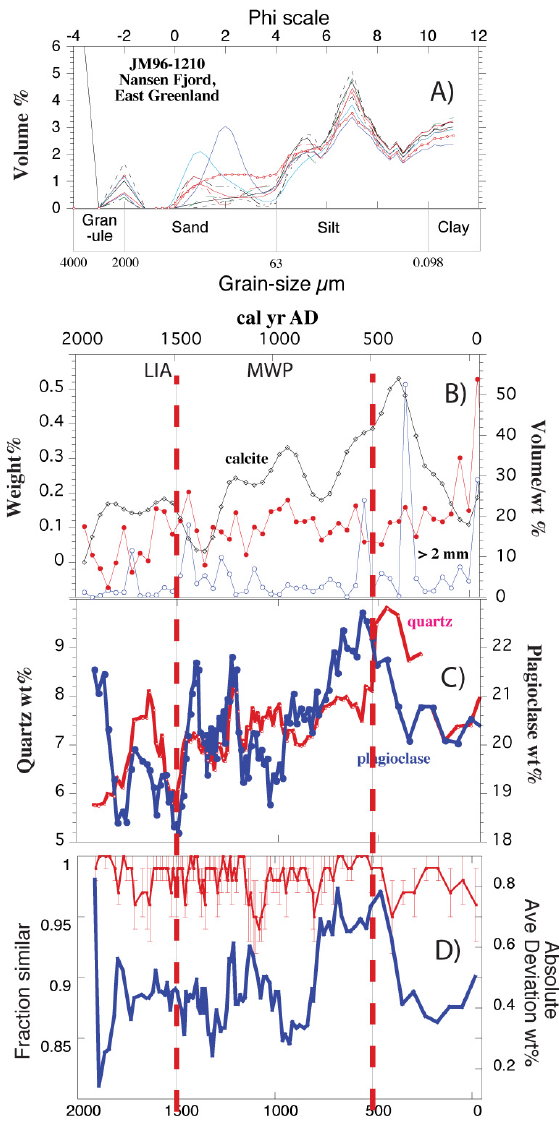
Fig. 5. Data from JM96-1210 and BS1191-K14, Nansen Fjord (Fig. 1). (A) Grain-size spectra from JM96-1210; (B) plots of the > 2mm sediment (blue), sand (red), and wt% calcite (smoothed); (C) smoothed wt% quartz and plagioclase; (D) downcore variations and error in the estimated similarity from the uppermost 5 qXRD sample mineralogy (red) and the absolute average deviation (wt%) from the 9 mineral groups. The two vertical dashed red lines rep- resent the timing of the latest Holocene cold events (Wanner et al.,